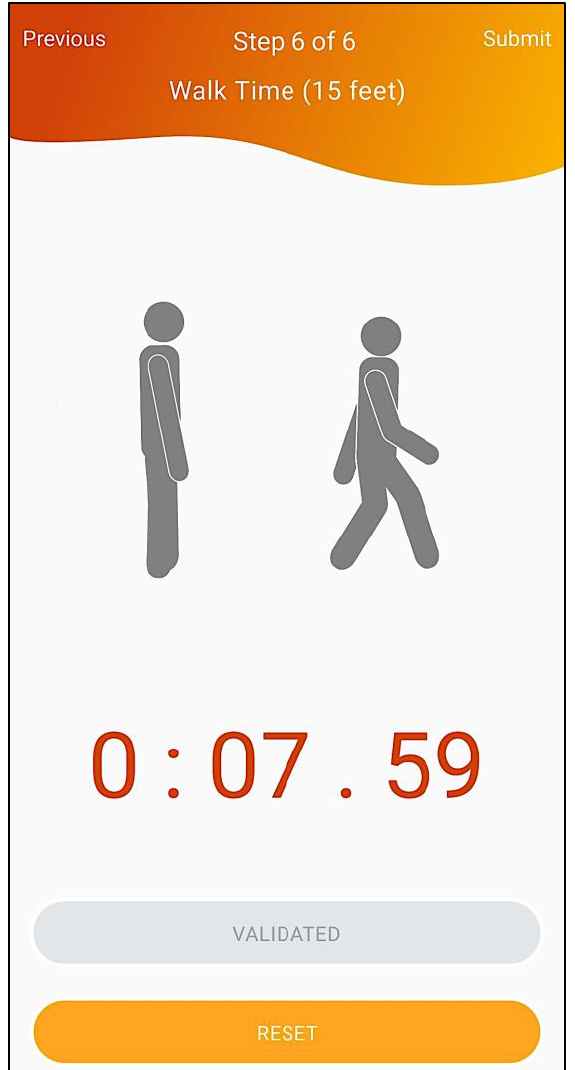
Figure 8 . Gait speed test. Figure 8. Gait speed